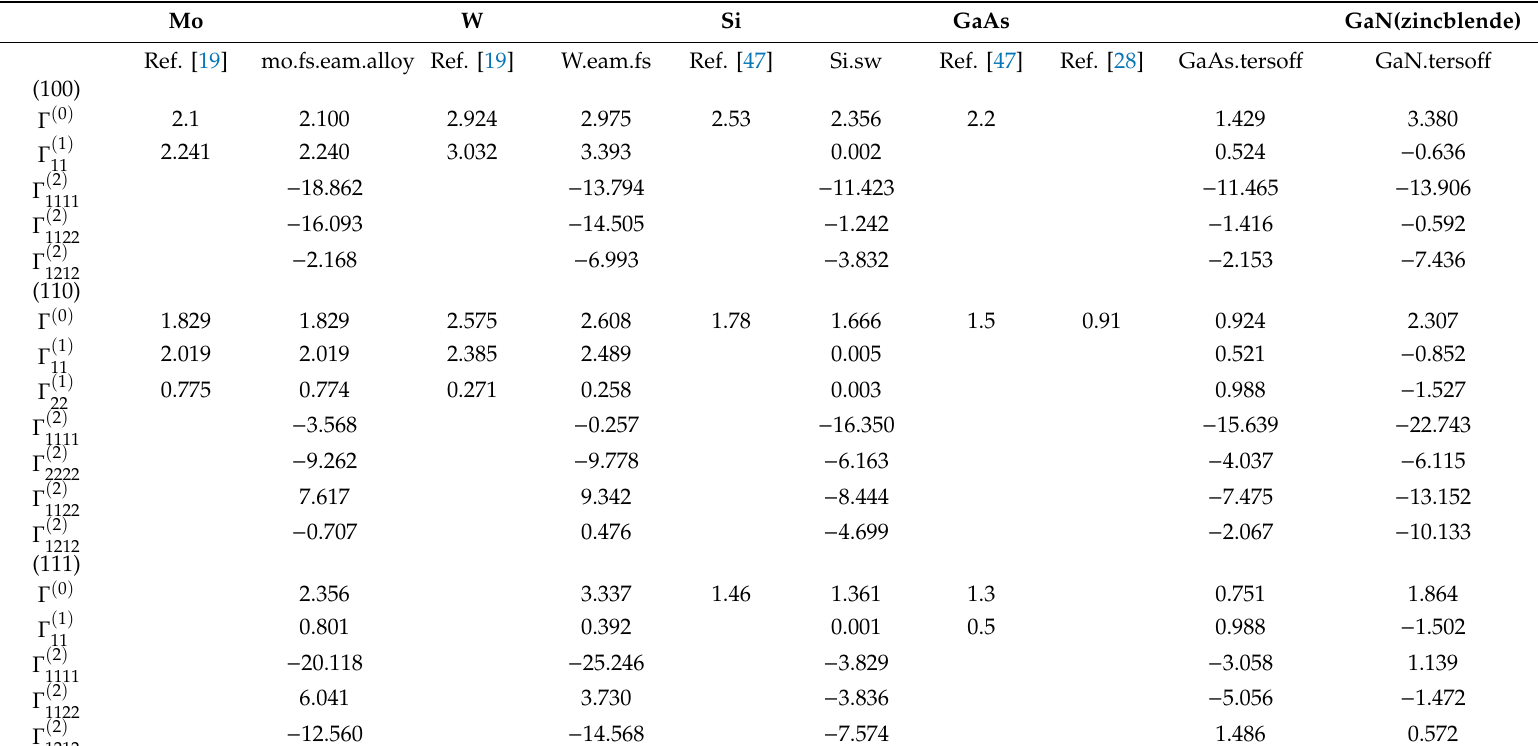
Table 4. Surface properties of body-centered-cubic (BCC), diamond and zincblende crystals (unit: J / m 2